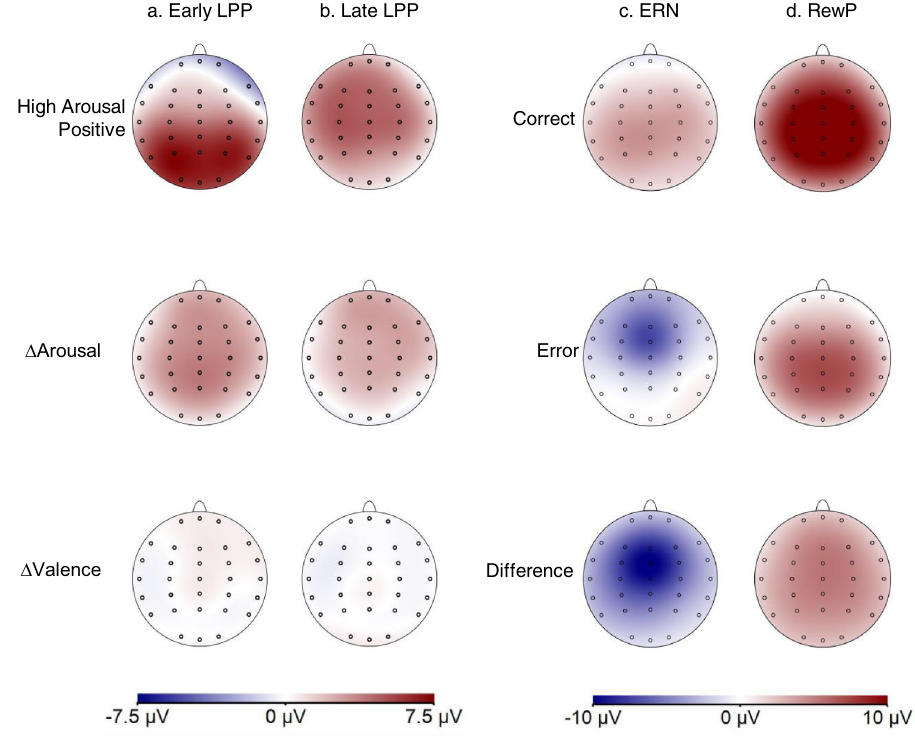
Fig. 4 Topographic maps showing the scalp distribution of the grand average ERPs. Increasing red intensity depicts positive-going ERP amplitudes, blue intensity depicts negative ERP amplitudes. a The early LPP for high-arousal positive images (top), the difference score for high arousal low arousal (middle), and the difference score for positive valence minus negative valence (bottom). b The equivalent topographic maps as in ( a ), but for the late LPP window. c Topographic maps in the time course of the ERN for correct trials (top), error trials (middle), and the difference score subtracting correct trials from errors (bottom). d The same pattern of topographic maps as in ( c ), but this time for the time course of the RewP after feedback stimuli. LPP: late positive potential; ERN: Error-related negativity; RewP: reward